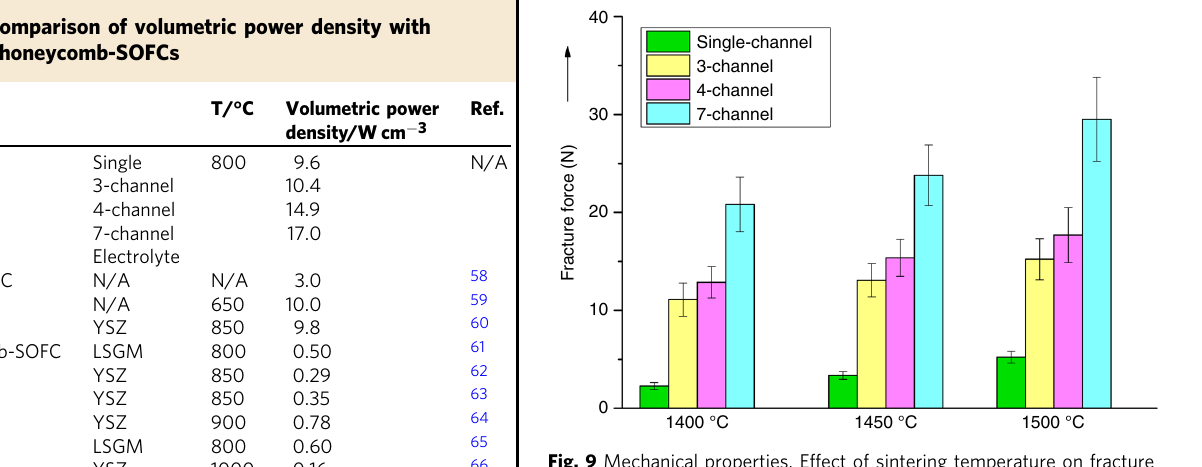
Fig. 9 Mechanical properties. Effect of sintering temperature on fracture force of 1-, 3-, 4- and 7-channel anode samples. Miniaturized ceramic